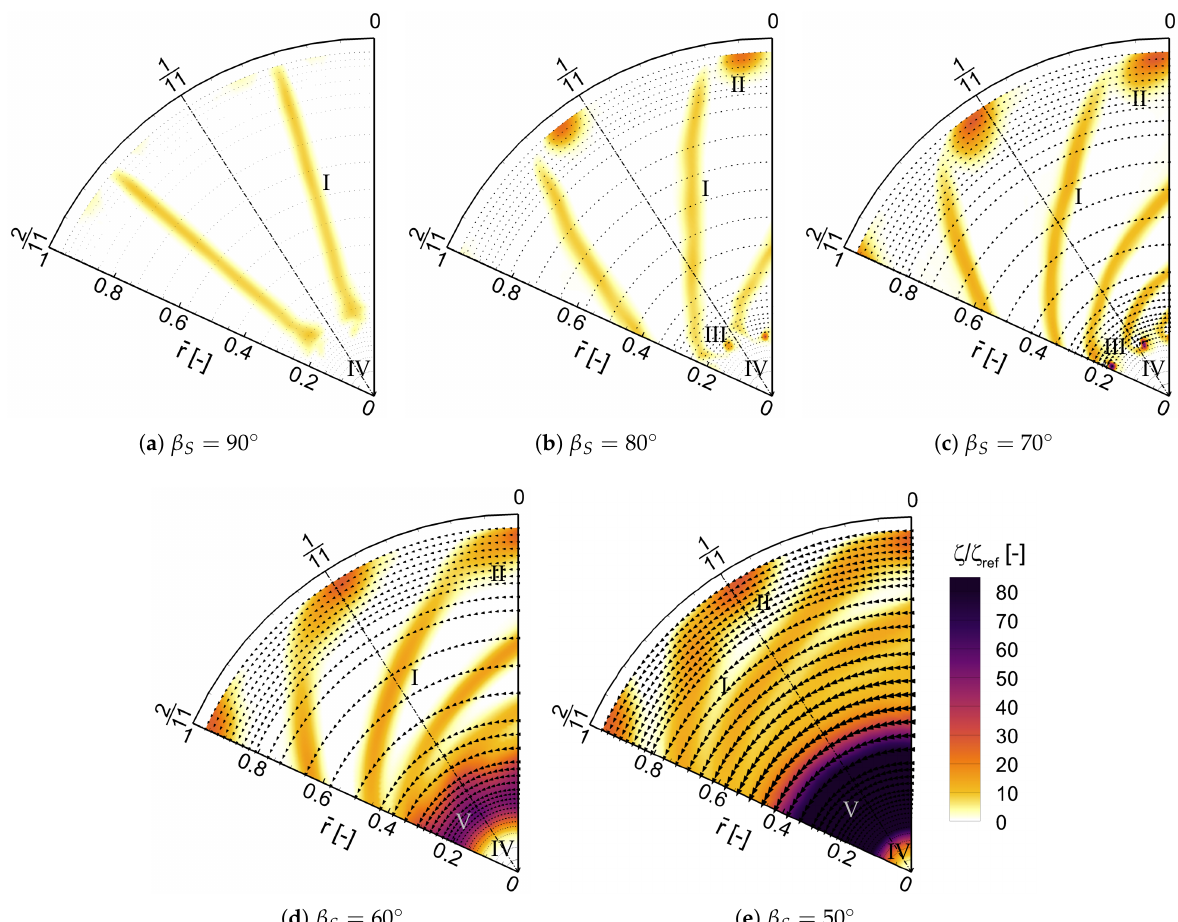
Figure 7. Wake field measurements from β S = 90 ◦ to 50 ◦ [I: profile losses, II: wall-blade interaction losses, III: blade tip losses, IV: blow hole flow, V: suspected open flow